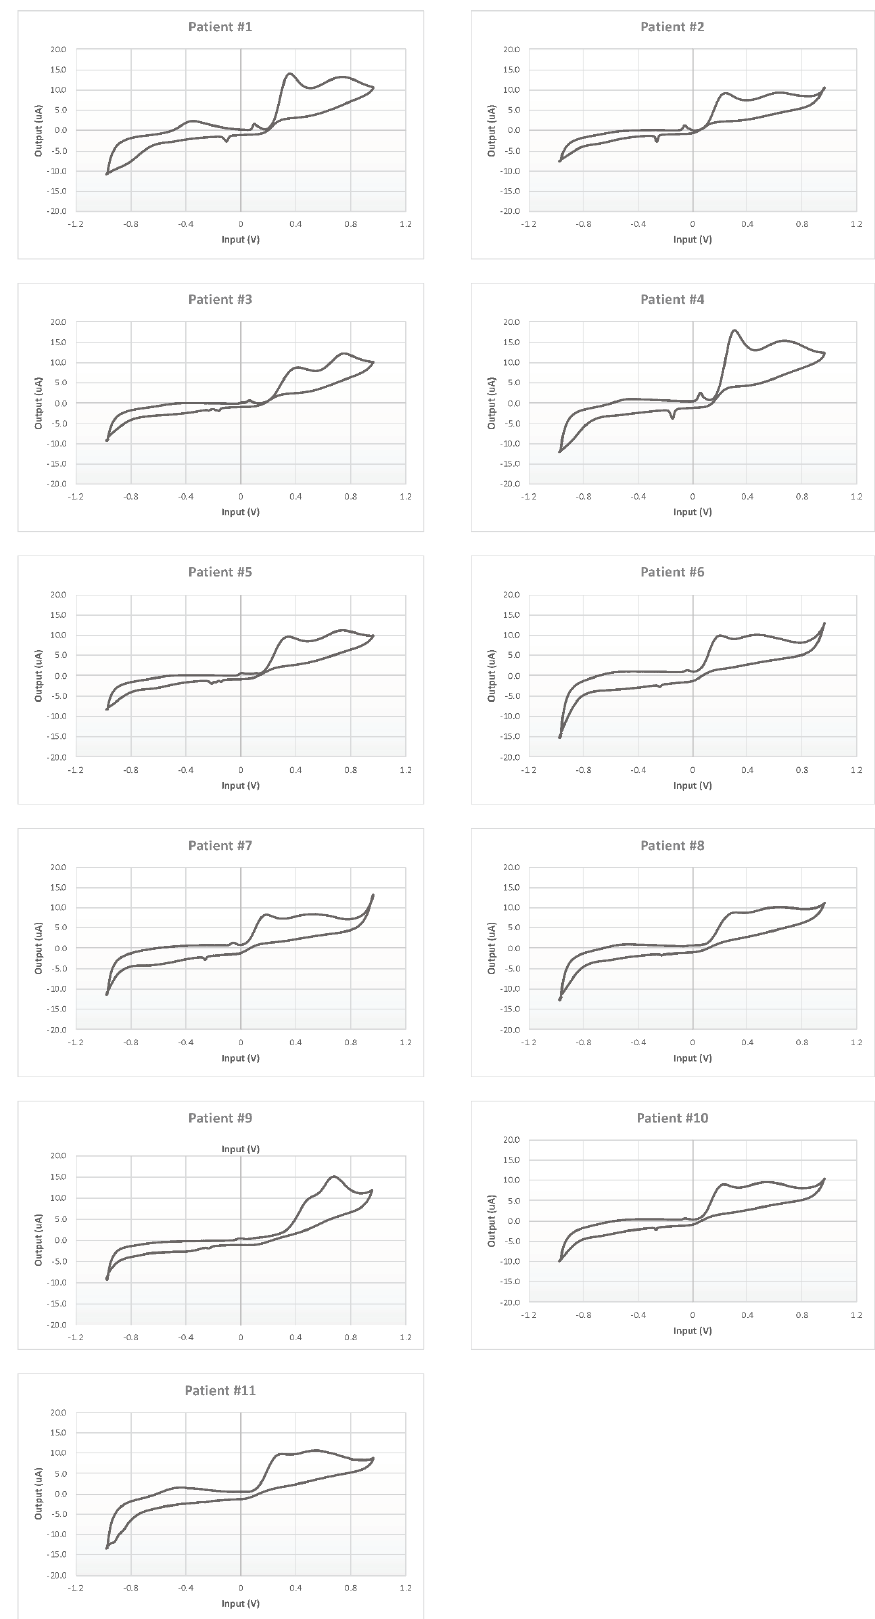
Figure 8. Cyclic voltammetry fingerprints of human CSF samples of each patient enrolled.